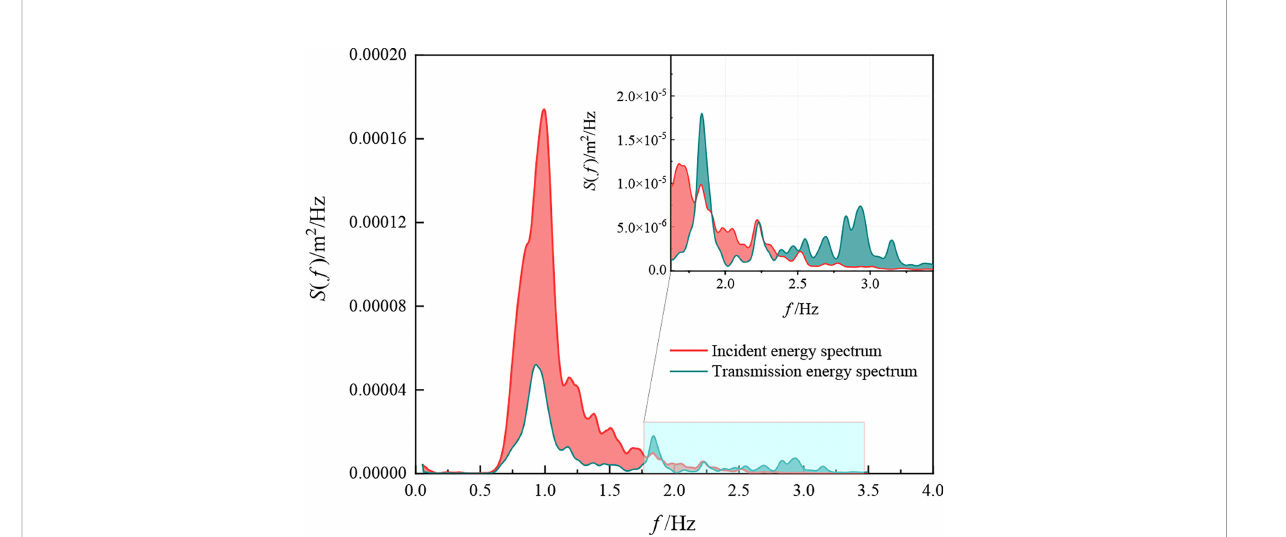
FIGURE 6 Comparison of incident and transmission spectra (M1, D = 0.27 m, H i = 0.043 m, T = 1 s).